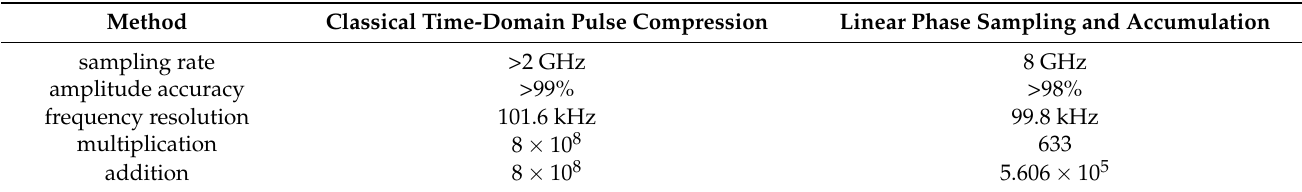
Table 1. Classical time-domain pulse compression method versus the LPSA